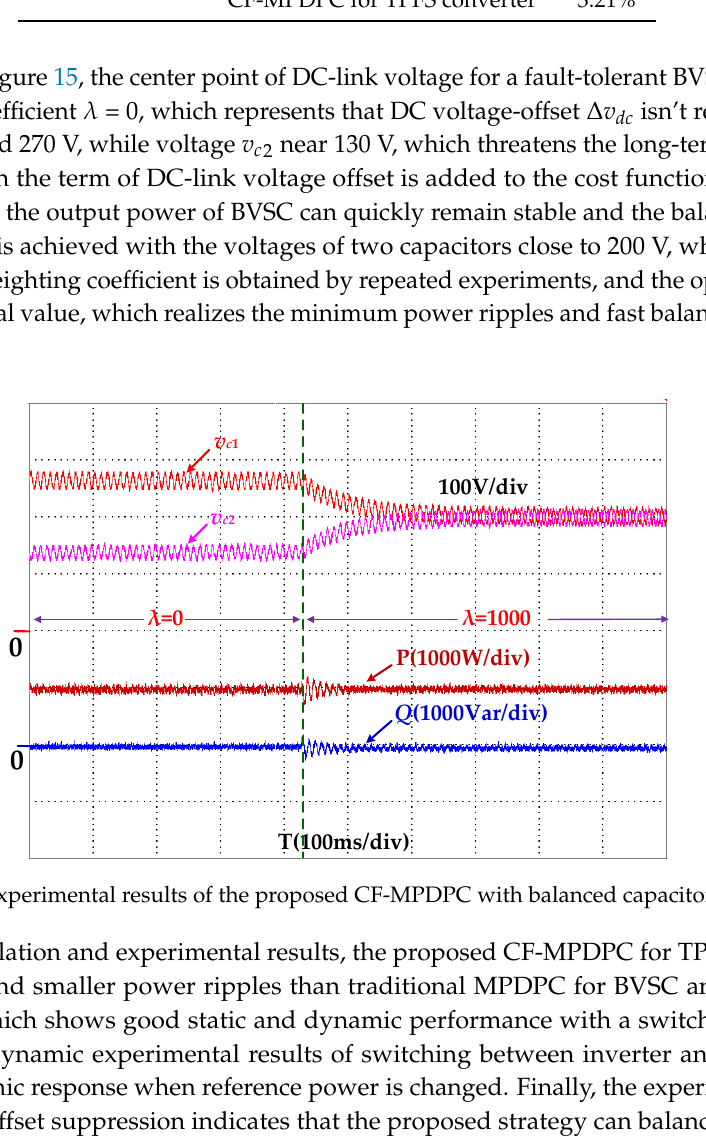
Figure 15. Experimental results of the proposed CF-MPDPC with balanced capacitor voltage.